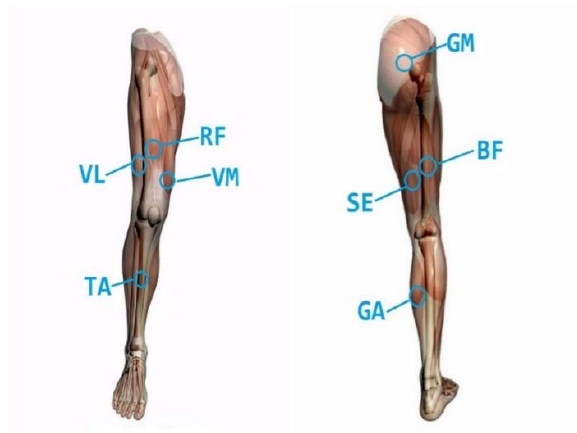
Figure 3. Description of lower extremity muscle position.